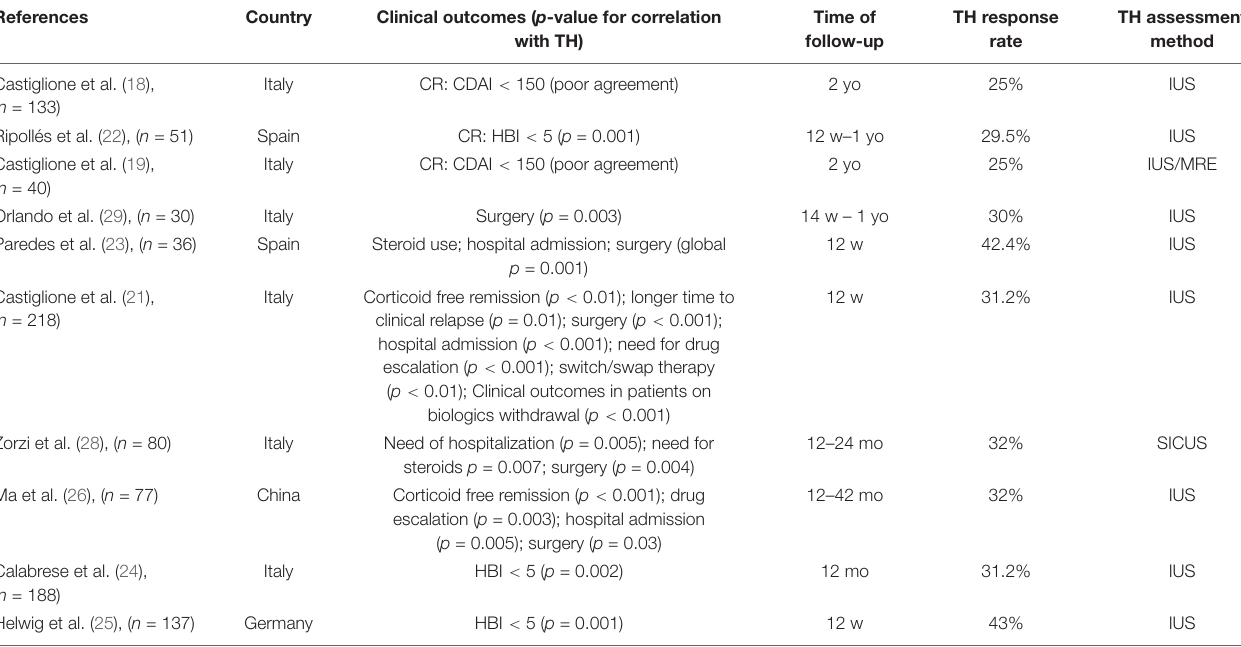
TABLE 2 | Relationship between transmural healing and clinical outcomes in patients with Crohn’s disease